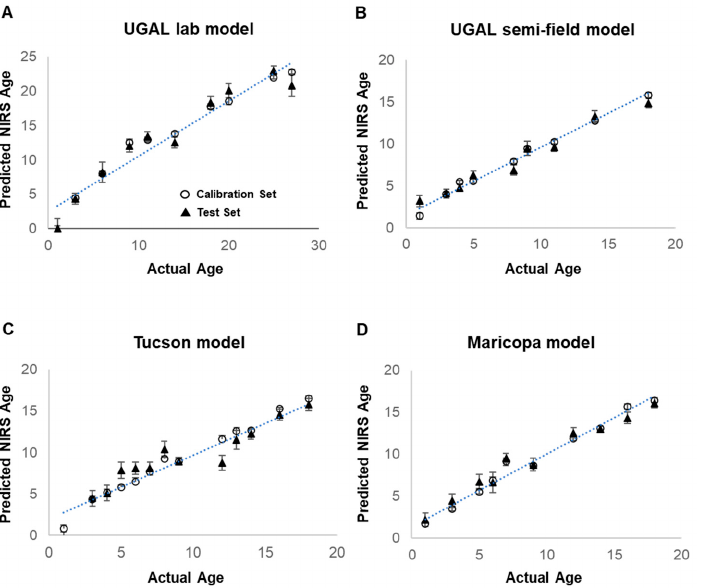
Figure 3 . Development of four models for NIRS age grading of Ae. aegypti mosquitoes. Predictive NIRS models for the age of female Ae. aegypti were generated for four different treatment groups of laboratory-reared mosquitoes. The UGAL lab model ( A ) was generated from 770 laboratory-reared UGAL female Ae. aegypti maintained at 27 ◦ C and 70% RH. The UGAL semi-field model ( B ) also utilized the UGAL line but maintained 748 adult mosquitoes in shaded field cages in Tucson, AZ. The Tucson model ( C ) was generated from 540 female Ae. aegypti from an F4 line established from eggs collected in Tucson, AZ, and maintained under laboratory conditions. Finally, the Maricopa model ( D ) was generated from 475 female Ae. aegypti using an F3 line established from Ae. aegypti eggs col- lected at our actual collection site in southeastern Maricopa County and maintained under laboratory conditions. For all models, open circles represent the calibration set and show mean predicted age at each timepoint of all mosquito spectra used in the model calibration. Solid triangles represent the test set and show the mean age prediction from mosquito spectra withheld from the model calibration and used to validate the model. The number of mosquitoes utilized for the prediction and test set, the spectral range and bend regions selected from the model, the number of factors and other parameters describing each model are shown in Table